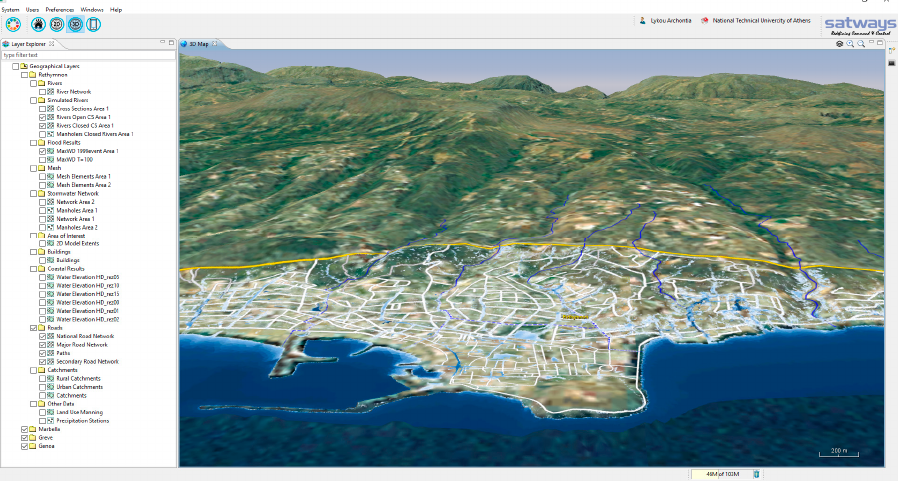
Figure 14. Flood risk results on the 3D map component for a particular case study area.